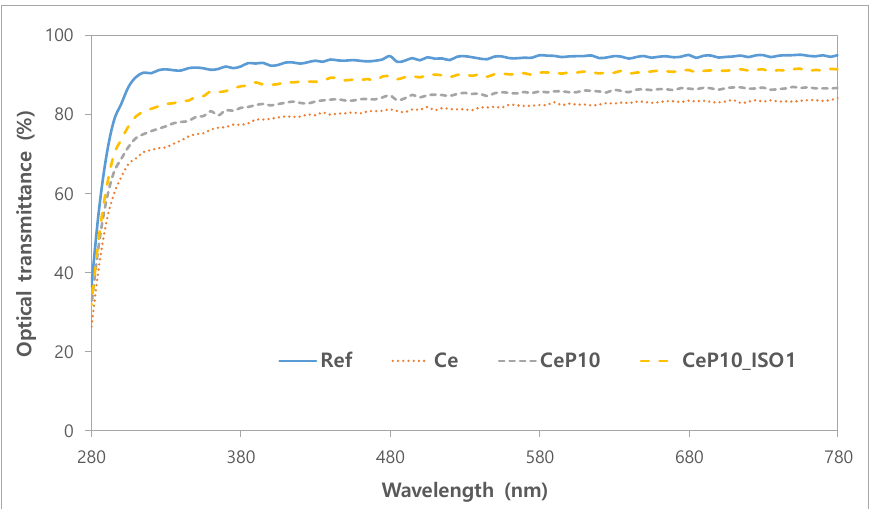
Figure 2. Optical transmittance of samples.